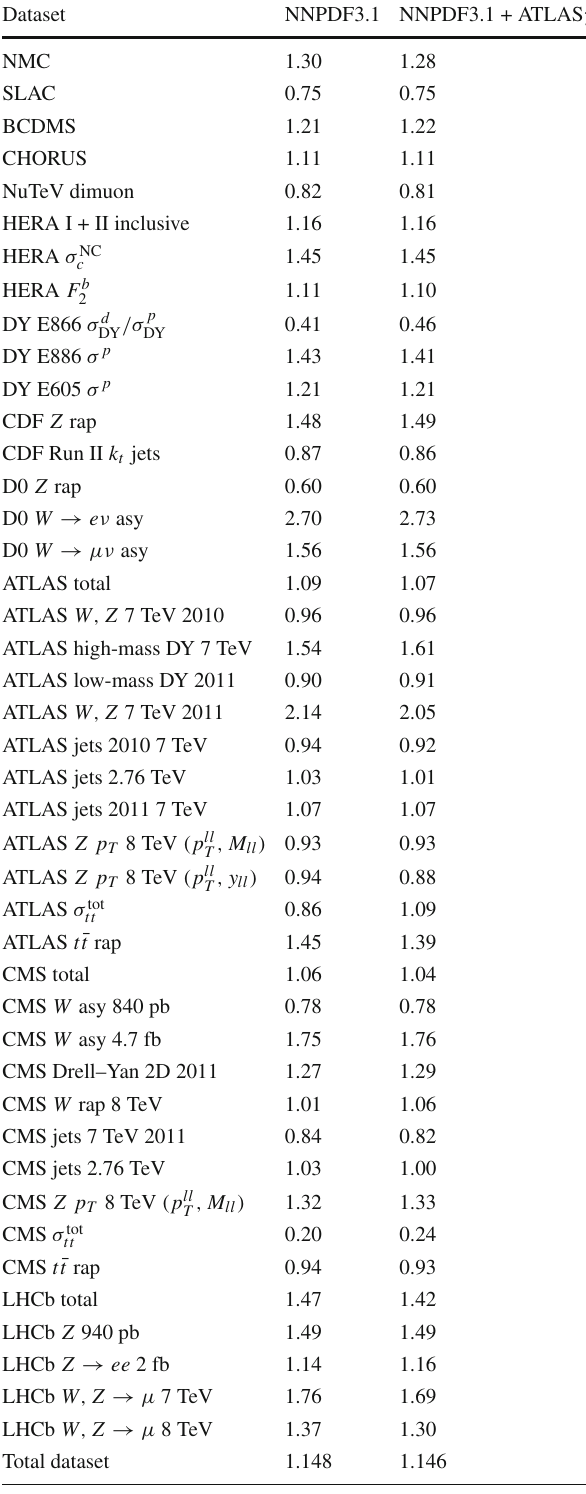
Table 4 The values of χ 2 / N dat for all the datasets included in the present analysis, comparing the results from the NNPDF3.1 and NNPDF3.1 + ATLAS γ fits. The corresponding values for the ATLAS 8 TeV direct photon data are reported in Table